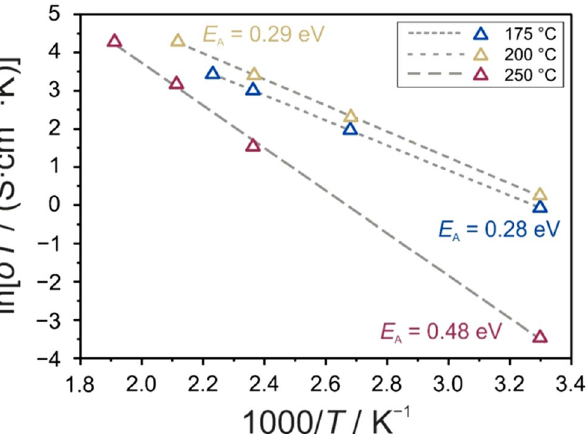
Figure 6. Arrhenius plots for the temperature dependence of conductivity for glassy 1.5Li 2 S–0.5P 2 S 5 –LiI heated at 175, 200 or 250 °C using a hot-press